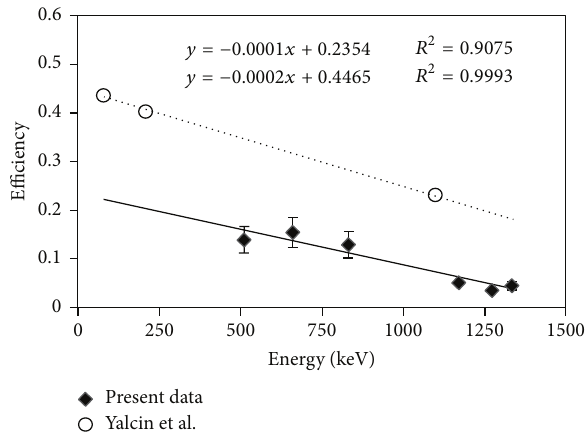
Figure 6: Comparison of measured and calculated detection effi- ciency of NaI(Tl) detector (source placed at 0,5 cm distance to the detector face).